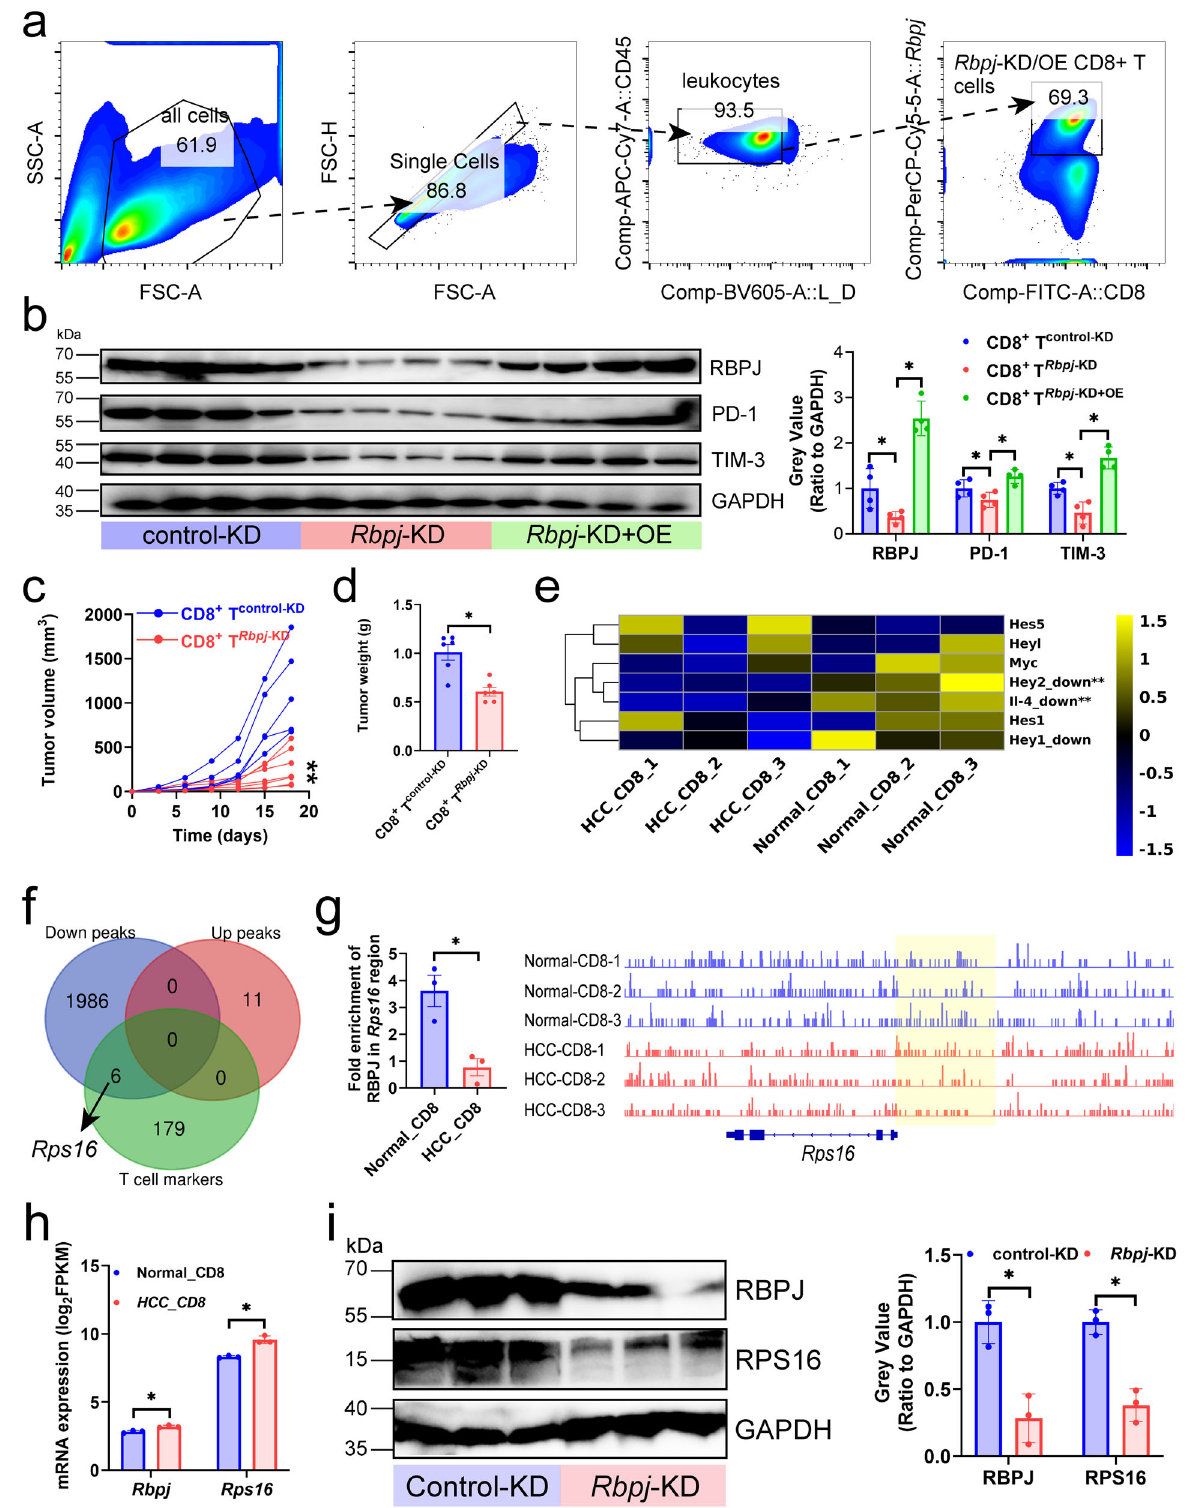
deacetylases. In the nucleus the Notch intracellular domain (NICD) displaces transcriptional repressors and forms a complex with RBPJ and Mastermind-like (MAML). MAML recruits transcriptional co-activators, such as the histone acetyltransferase p300, forming a Notch activator complex that culminates in the transcription of Notch target genes 7 . The expression of Hey2 and IL-4 (Notch target genes) in HCC in fi ltrating CD8 + T cells was